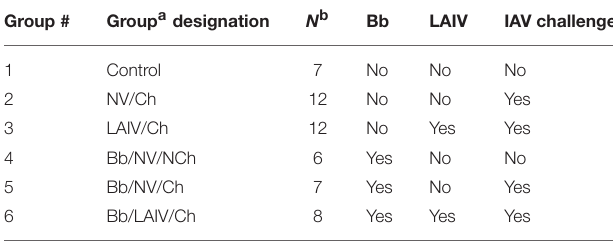
TABLE 1 | Experimental groups and treatments in the